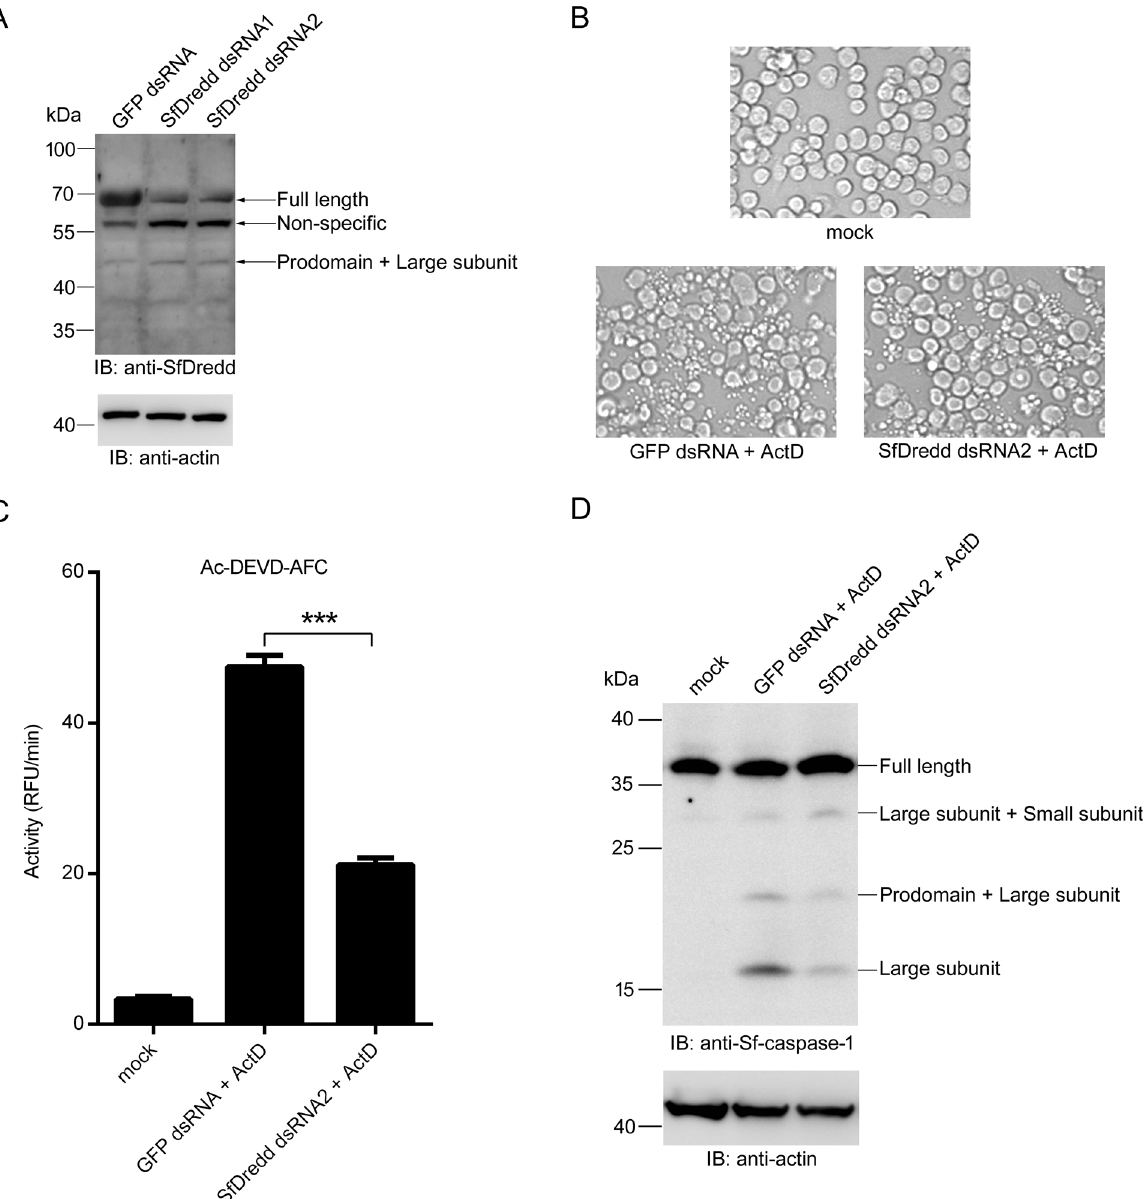
Fig 9. Knockdown of SfDredd led to decreased apoptosis induced by ActD. (A) 5×10 5 Sf9 cells were transfected with dsRNA (1 μ g) of SfDredd -dsRNA or GFP -dsRNA, 24 h later, cells were harvested and subjected to immunoblotting using antibody against SfDredd. (B-D) 5×10 5 Sf9 cells were transfected with dsRNA (1 μ g) of SfDredd -dsRNA or GFP -dsRNA, 24 h later, cells were treated with ActD at a final concentration of 250 ng/mL for 6 h and subjected to the following analyses: (B) Cell images were taken under a microscope (magnification ×200). (C) Cell lysates were incubated with Ac-DEVD-AFC and subjected to caspase activity assay. Caspase activity was indicated as the changes in relative fluorescence units (RFU) per minute. The data were presented with the SD from three independent experiments, and statistical significance was calculated by t test, *** P < 0.001. (D) The cleavage of Sf-caspase-1 was detected by immunoblotting using an antibody against